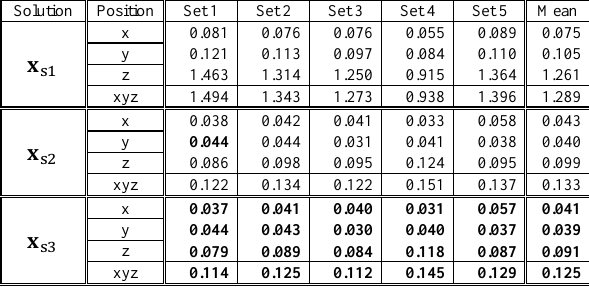
Flip Correction: Figure 9 shows the impact of the proposed method for resolving and correcting flip ambiguity